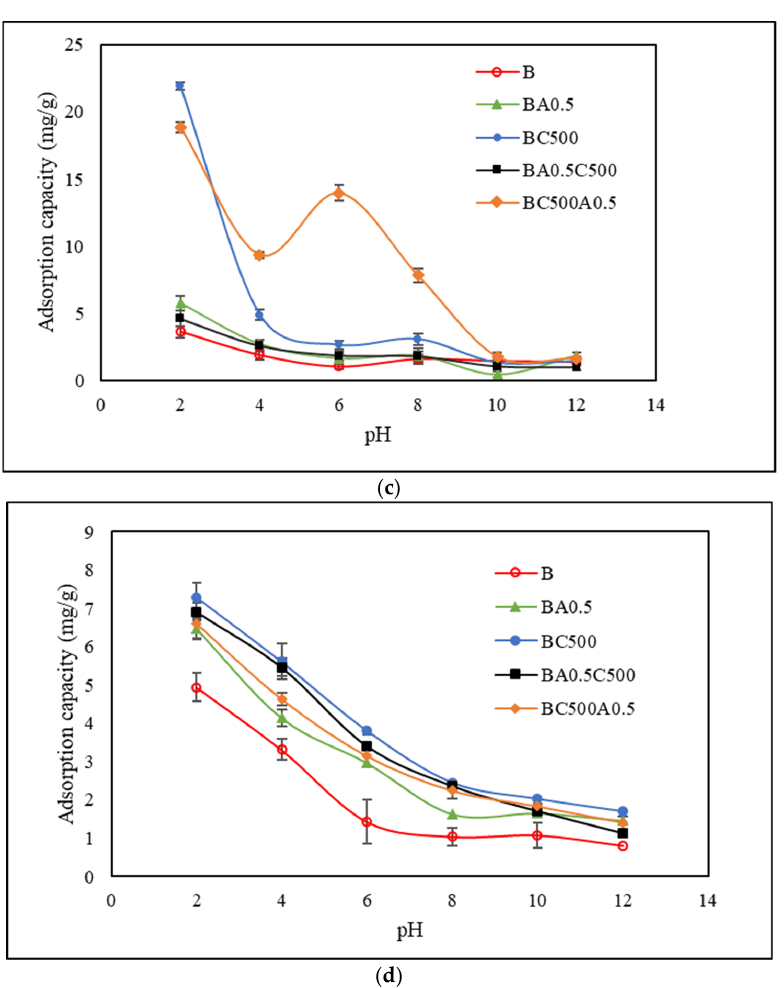
Figure 6. Adsorption capacity of modified and unmodified bentonite for paraquat ( a ); 2,4 - D ( b ); atrazine ( c ); and diuron ( d ) at various pH and at 50 ppm.